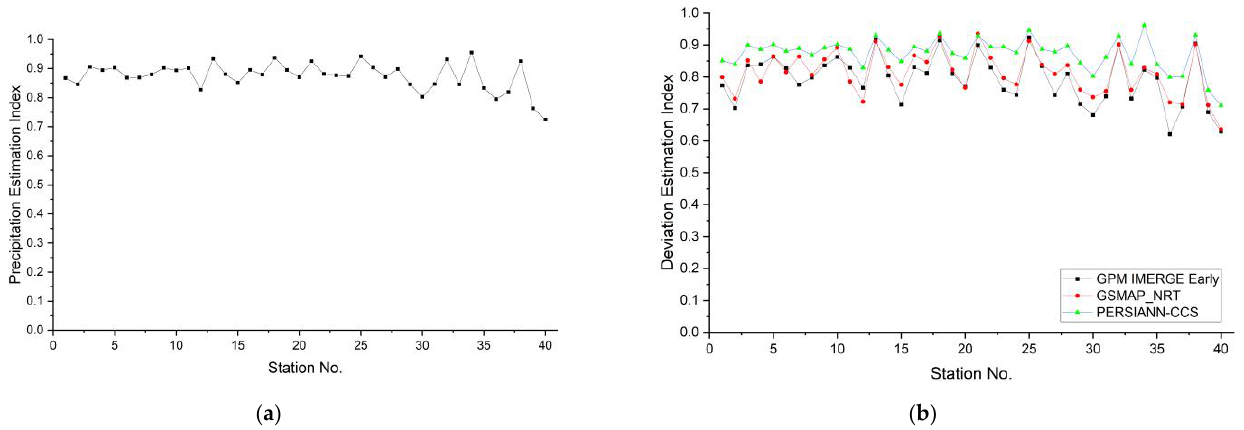
Figure 12. PEIs and DEIs of 40 ground-based rain gauge stations. ( a ) Rain gauge PEI; ( b ) DEIs of three satellites.